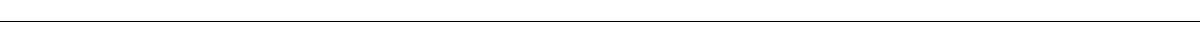
Fig. 5 HFB response time-locked to the onset of individual recall events. a Stimulus response in category selective electrodes to images from the preferred and non-preferred categories during the picture viewing stage. b Recall-related response in the same electrodes time-locked to the onset of individual recall events, showing both a sustained baseline-shift and a transient event-related component. The transient component involved both amplitude increase and decrease anticipating the recall of items from the preferred and non-preferred categories, respectively. The blue line presents t -values from a successive paired t -test comparing recall of preferred vs. non-preferred category. Signi fi cant time bins are indicated in yellow ( p < 0.05, cluster-based correction using Monte Carlo simulation). Shaded areas re fl ect unbiased within electrode corrected 95% con fi dence interval 72 . c , d an alternative contrast applied to the same electrodes showing stimulus response of preferred images (top third responses) and non-preferred images (bottom third responses) during the picture viewing stage, and the corresponding responses during recall (same notations as in b ). Here again a transient differential activity component appeared to anticipate the recall event by ~1.5 s. e , f Applying the same contrast (i.e. preferred vs. non-preferred images) in early visual electrodes (V1 + V2) did not reveal any signi fi cant recall-related response. g Comparing recall onset response in category selective electrodes to the immediate prerecall baseline using a mixed-effects model revealed a signi fi cant interaction between preference and time-bin (F(1,192) = 5.04, * p < 0.05), further supporting the observation that HFB amplitude was increased/decreased during recall of preferred/non-preferred images, respectively. h Anatomical location of face-selective (red), place-selective (green), V1 (blue) and V2 (light blue) electrodes on an in fl ated template brain. See Supplementary Table